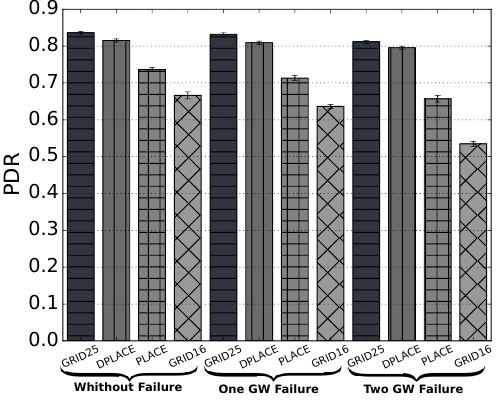
Figure 3. Packet Delivery Ratio (PDR) for analyzed LoRaWAN gateway placement